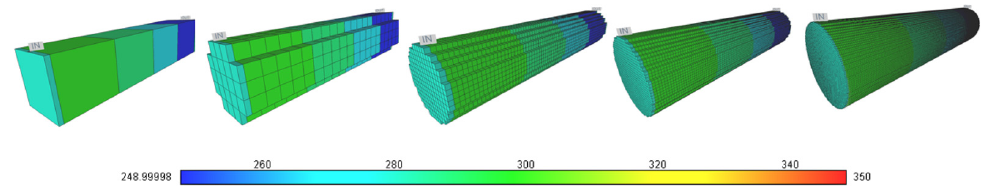
Figure 9. General view of all models used for permeability cube analysis. Table 3. Model parameters.